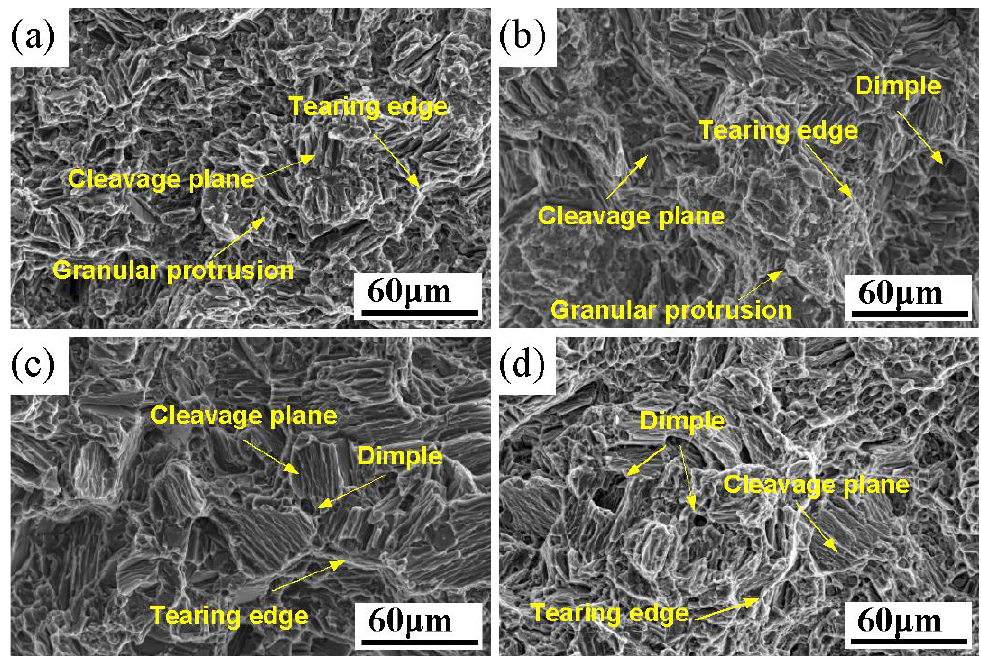
Figure 11. Tensile fracture morphology of the Mg-3Y-4Nd-2Al alloy after solution treatment for different time periods: ( a ) 0 h, ( b ) 2 h, ( c ) 16 h, and ( d ) 48 h.